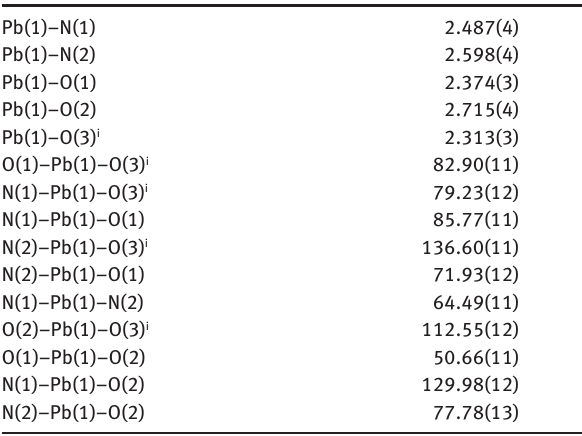
Table 1: Selected bond lengths (Å) and angles (°) for the complex